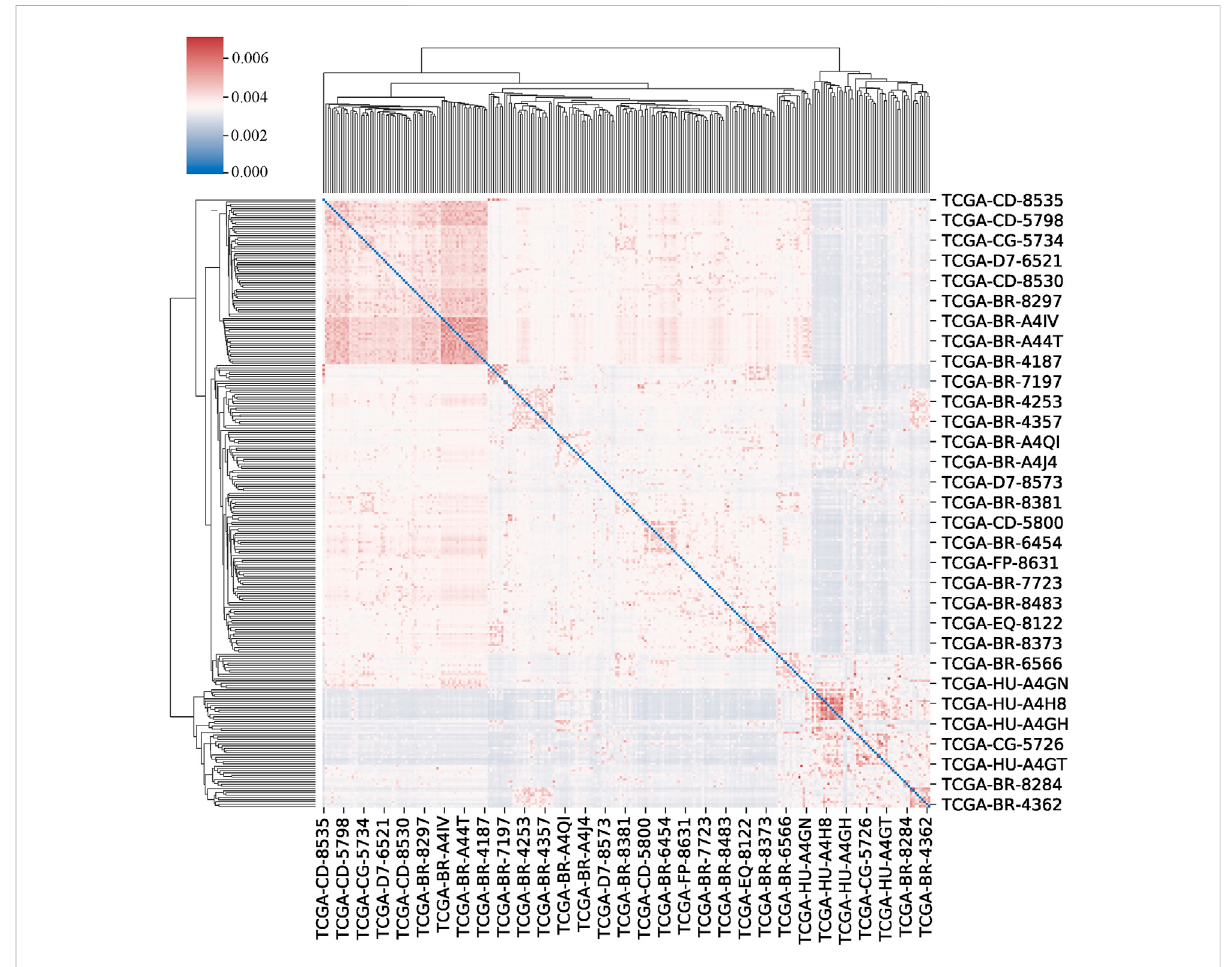
FIGURE 4 The clustermap of patients. The clustermap shows the clustering relationship among multiple samples, with red representing high correlation and blue representing low